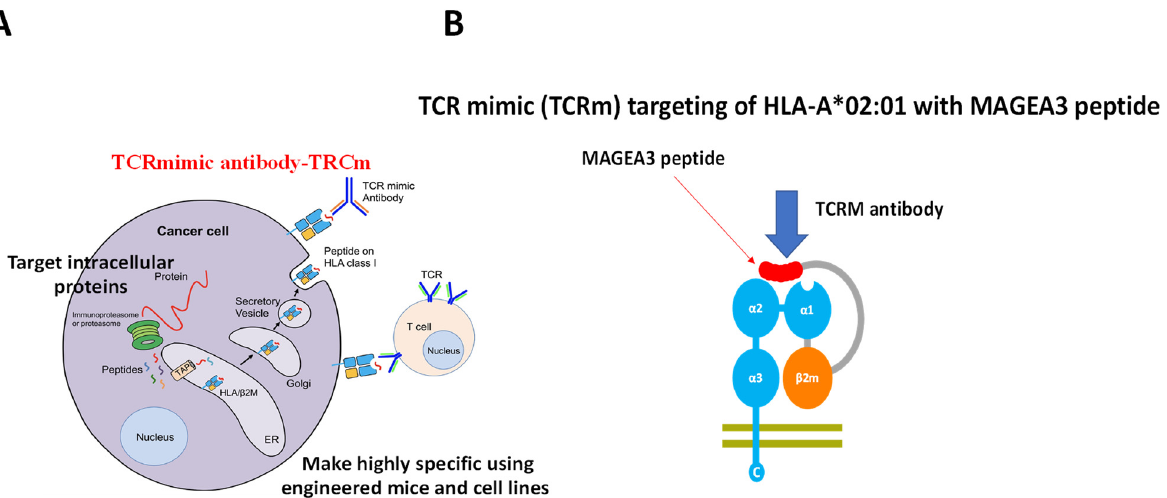
Figure 4. ( A ) TCRm antibody principle. The principle from [19]. ( B ) Tcrm antibody interaction with HLA-2- β 2m-peptide peptide